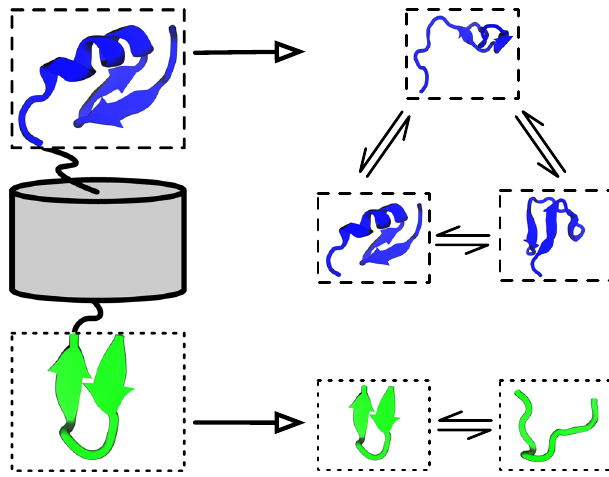
Fig.1|TheiVAMPconceptasvisualizedbymodelingdynamicsofaproteinthat has two independent, fl exible regions separated by a rigid barrel. iVAMPnets learn an assignment of the C- (blue/top) and N-termini (green/bottom) into inde- pendent subsystems from molecular dynamics trajectories (left column). More- over, the dynamics of both termini are modeled with statistically independent VAMPnets (right